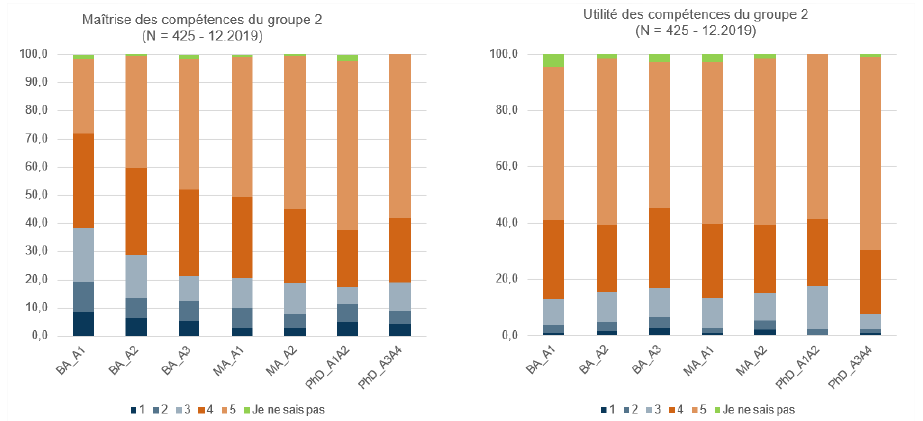
Fig. 2. Answers of the students to mastering and utility of skills for Information